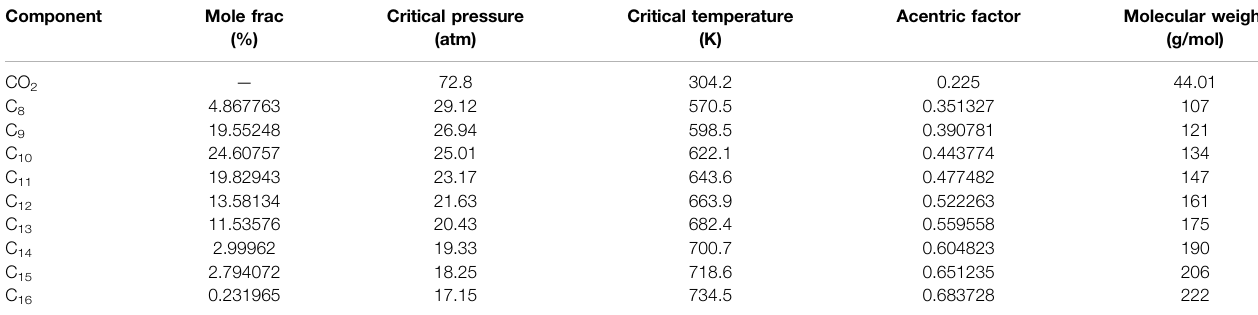
TABLE 4 | Composition and properties of experimental oil components. Component